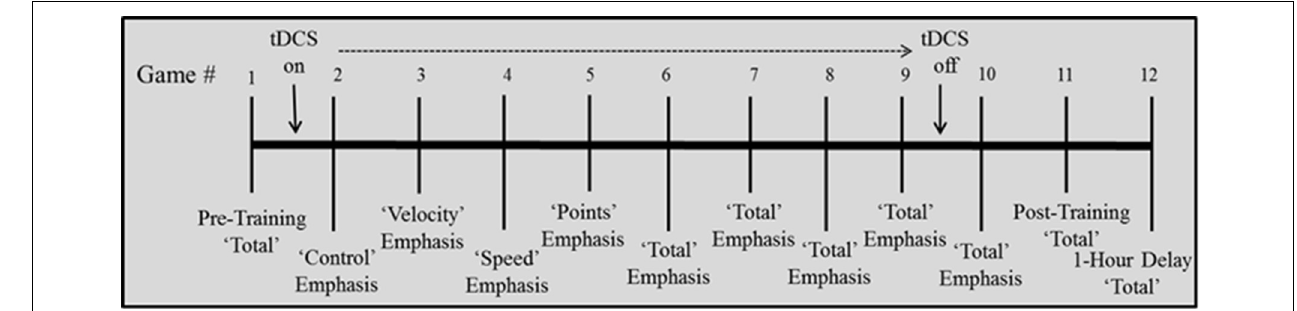
FIGURE 2 | Depiction of training